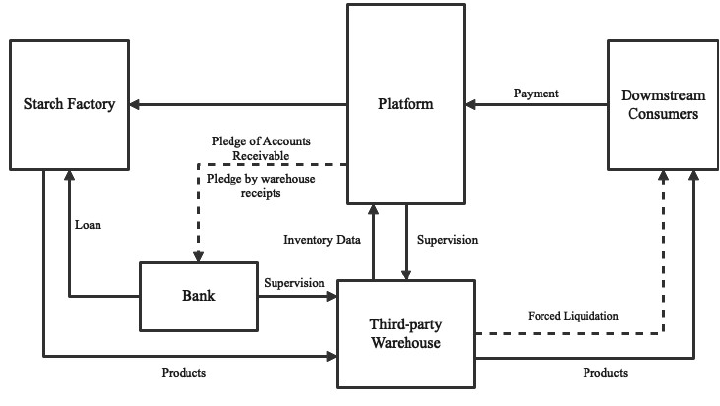
Figure 10. Inventory financing